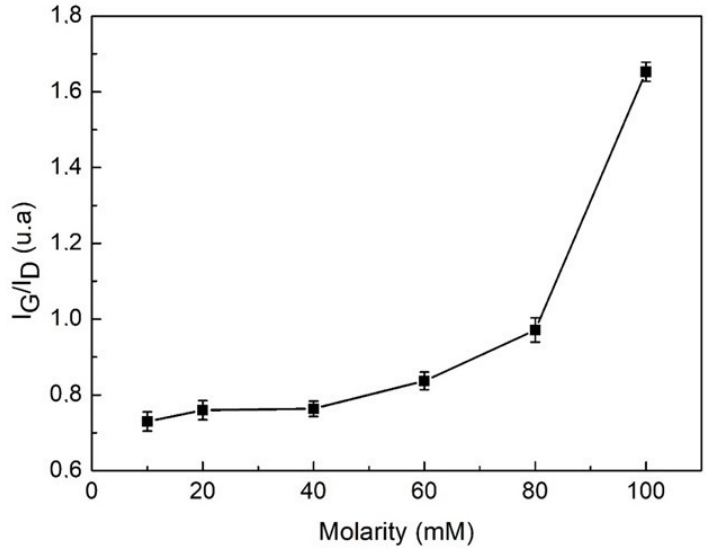
Figure 8. I D /I G ratio of MWCNTs dispersed in water with different TX-100 molarities. Table 2. Description and notation of the samples used for the mechanical properties characterization. Description of the Mixtures Used for Building the Test